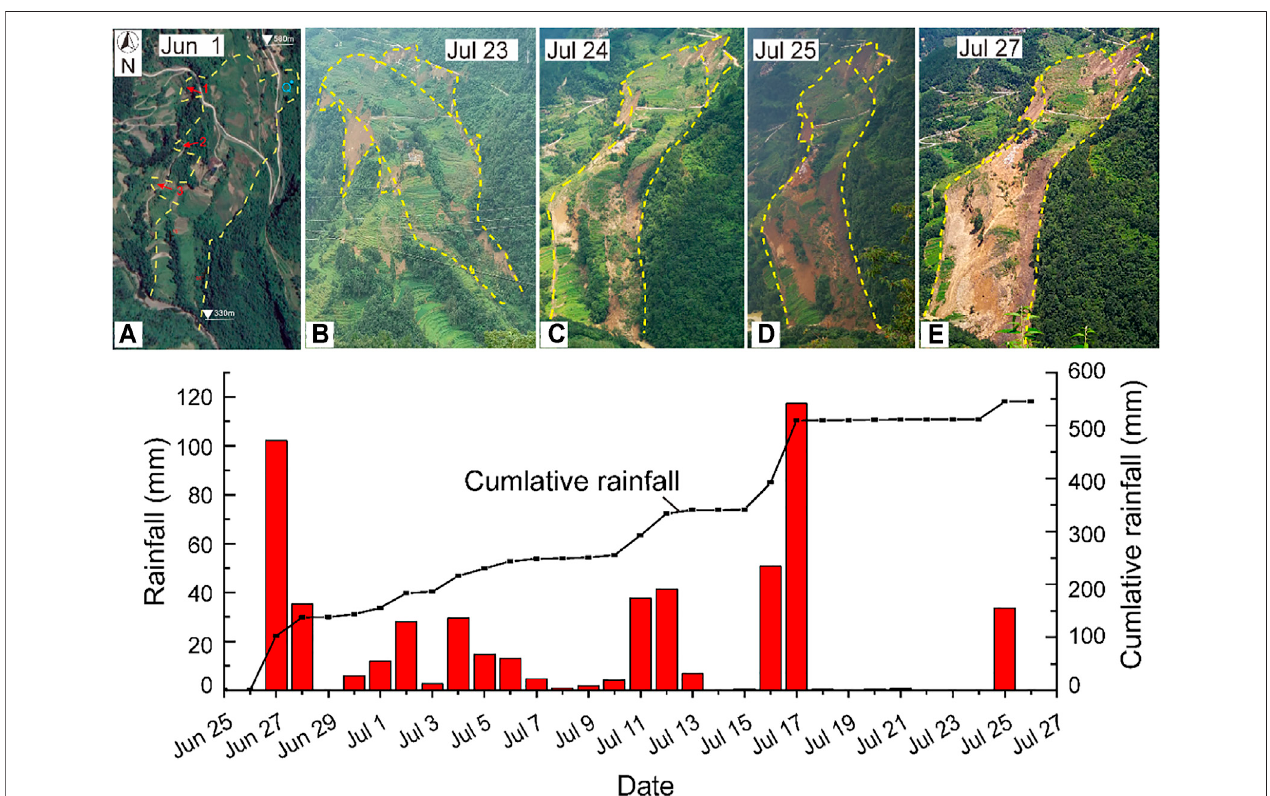
FIGURE 4 | Deformation characteristics and rainfall vs.